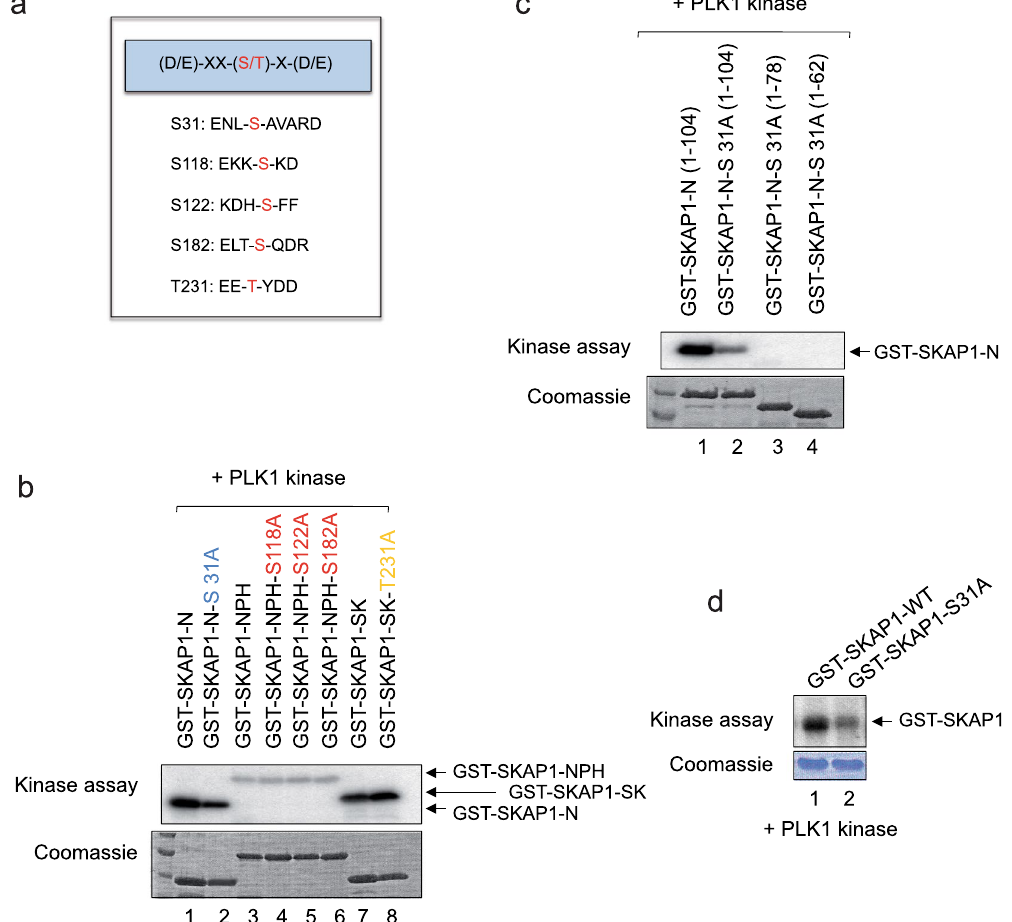
Figure 2. PLK1 phosphorylates the S31 site in SKAP1 N-terminal region. (Panel a) Sequence of SKAP1 showing putative PLK1 phosphorylation sites. (Panel b) PLK1 phosphorylates GST- SKAP1-S31. Purified GST- fusion proteins of different regions in SKAP1 were incubated with purified recombinant PLK1 kinase in an in vitro phosphorylation assay. The GST fusion proteins included SKAP1, N-terminal (N-SKAP1; residues 1–104), N-SKAP-S31A, SK region (SK; residues 209–285), SK-T231A or N plus PH; N-PH S118A, N-PH S122A, N-PH, S182A. (Panel c) PLK1 phosphorylates GST-SKAP1-S31A. GST-fusion proteins as outlined were incubated with purified PLK1 kinase in an in vitro phosphorylation assay. Panel d: Full-length GST-SKAP1-WT and S31A mutant were incubated with recombinant PLK1 kinase in an in vitro phosphorylation assay. Coomassie blue staining shows equal